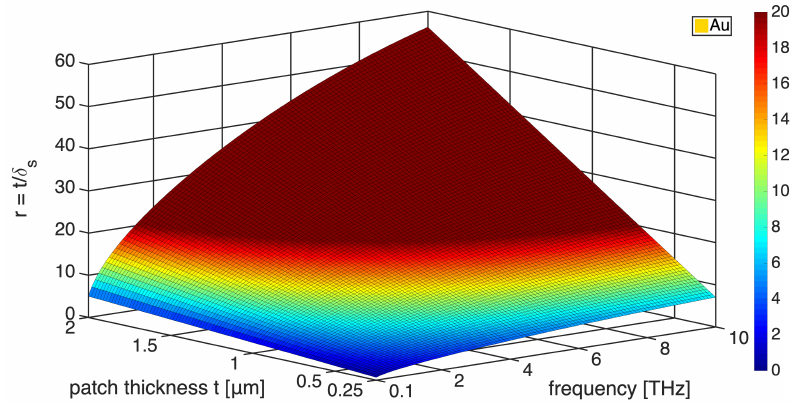
Figure 5. A 3 D representation of the ratio metal thickness to penetration depth r = t / δ s ( δ s : penetra- tion depth, t : thickness of metallic portions) for Au at 0.1–10 THz frequency range. The color scale represents the values of the ratio r